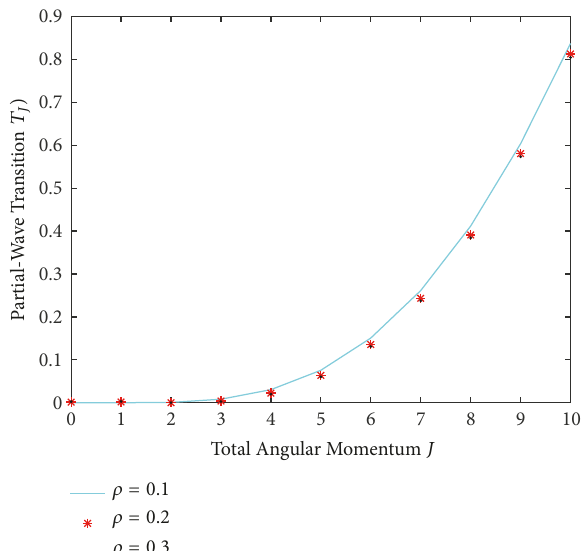
Figure 1: DKP partial-wave transition for the Hellman potential as a function of total angular momentum 𝐽 with 𝑎 = 𝑏 = 0.15 and 𝐸 𝑛,𝐽 = 𝑚 = 1